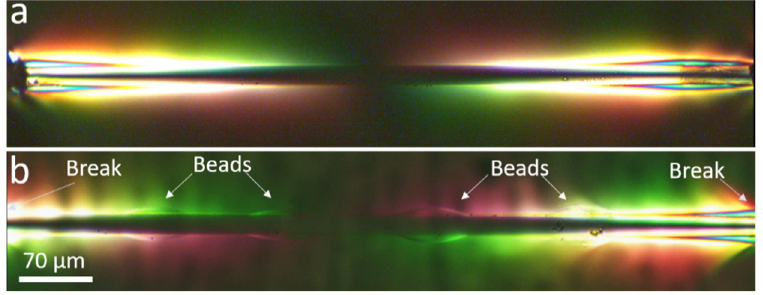
Figure 9. Fibre fragments between fibre breaks before saturation. ( a ) Control. ( b ) Beaded fibre.